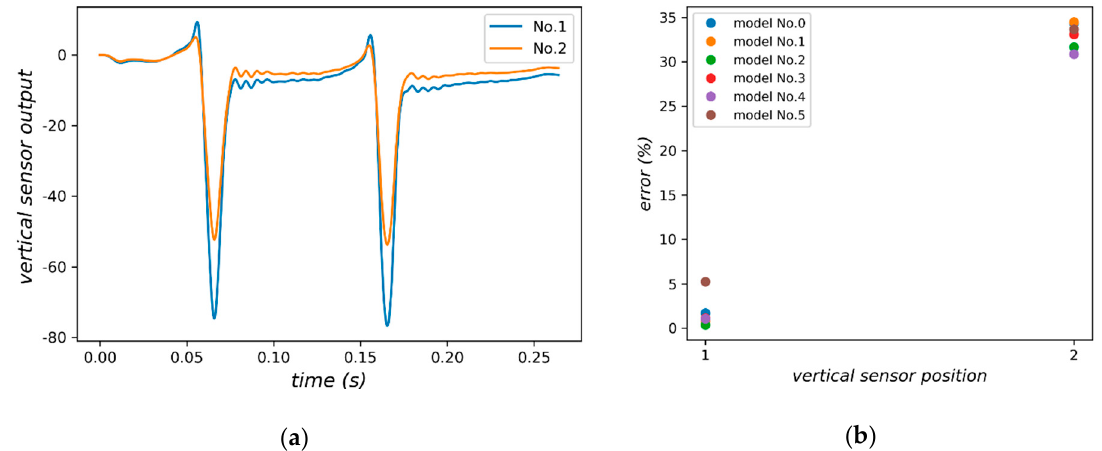
Figure 15. Placement of vertical sensors.